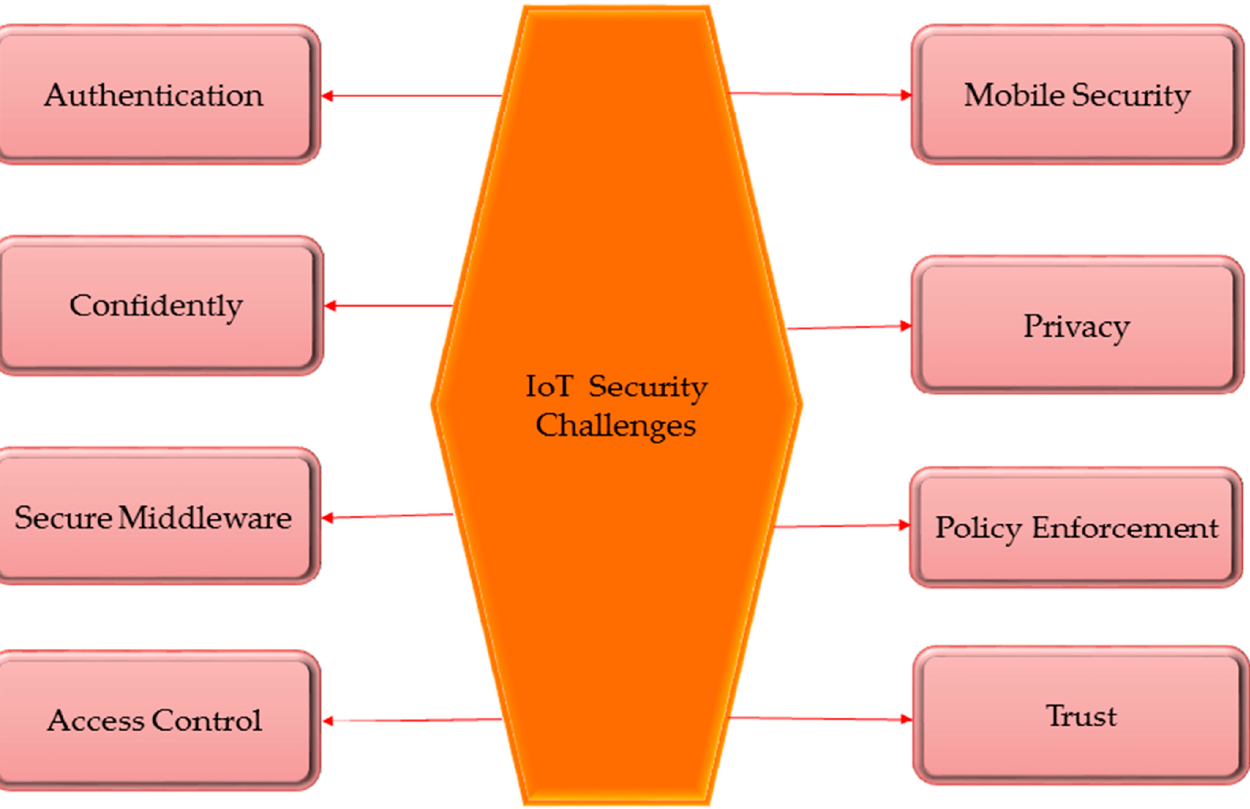
Figure 7. Security Challenges of IoT [81,82].